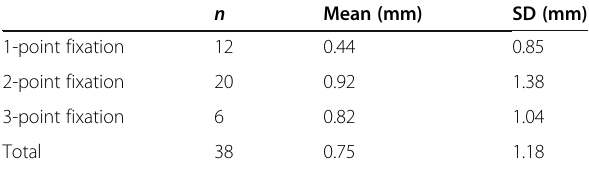
Table 2 Displacement amount according to fixation numbers